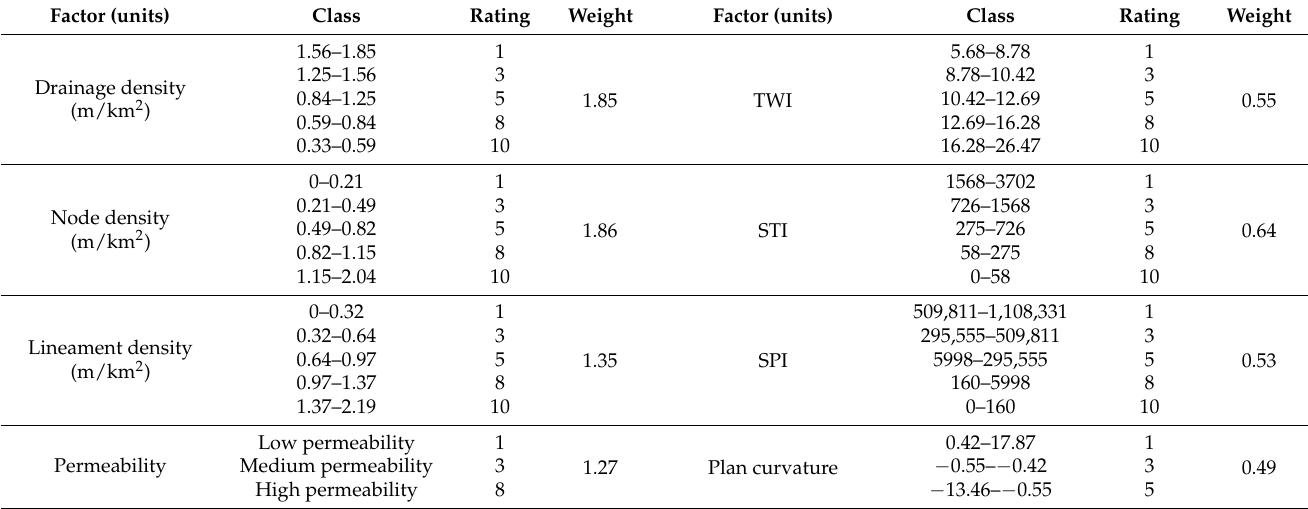
Table 1. Classification and standardization of groundwater potentiality